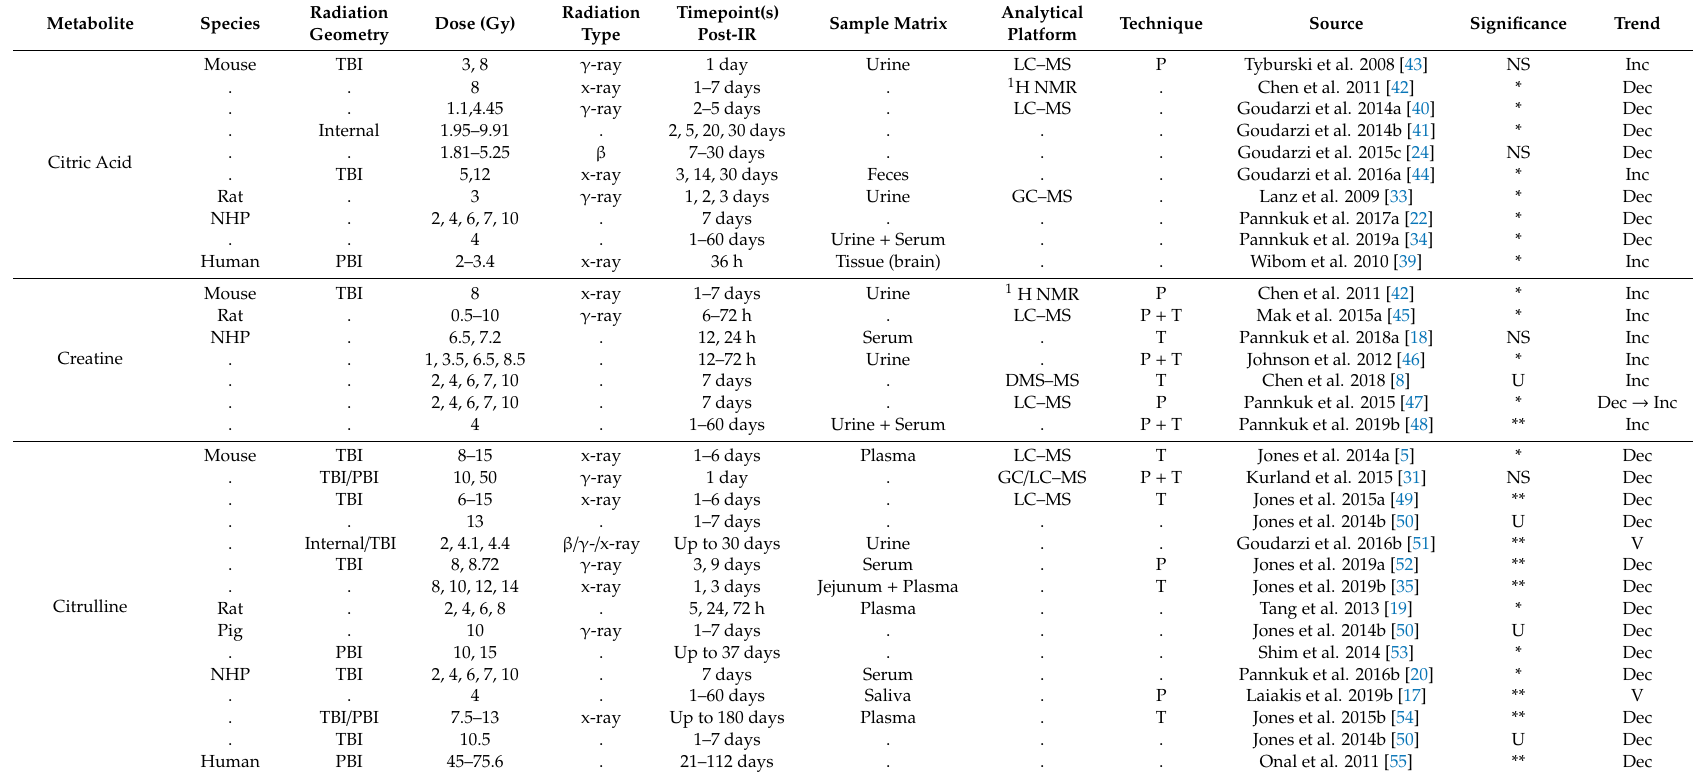
Table 1. Metabolites most frequently detected in review of several animal and human